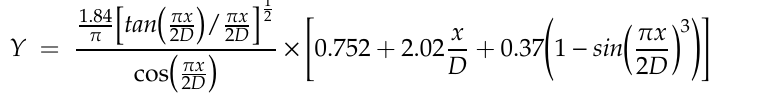
( b ) η = 1.85%; ( c ) η = 2.5%; ( d ) η =